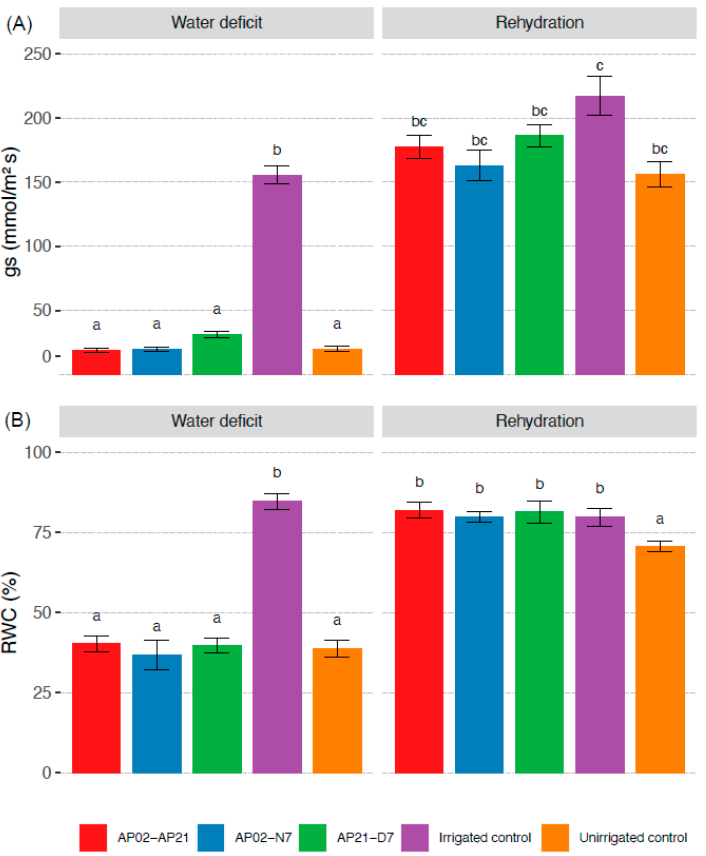
Figure 2. Stomatal conductance (gs) ( A ) and leaf relative water content (RWC) ( B ) in perennial ryegrass after 10 days without irrigation and 3 days after rehydration. AP02–AP21: Herbaspirillum